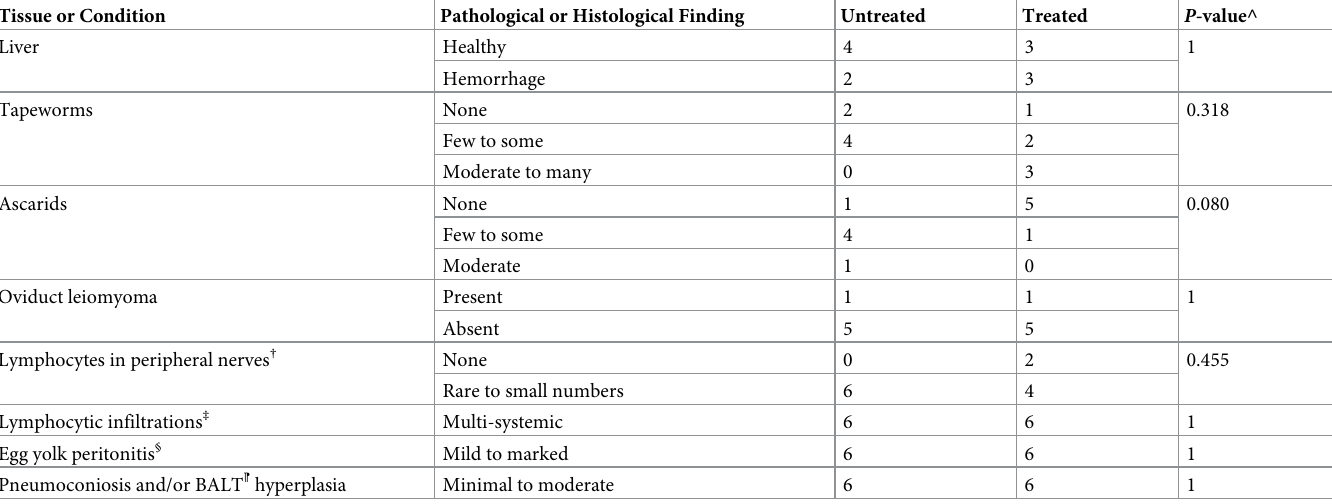
Table 2. Pathologic and histological findings at necropsy of ivermectin-treated ( n = 6) and untreated ( n = 6) chickens. Tissue or